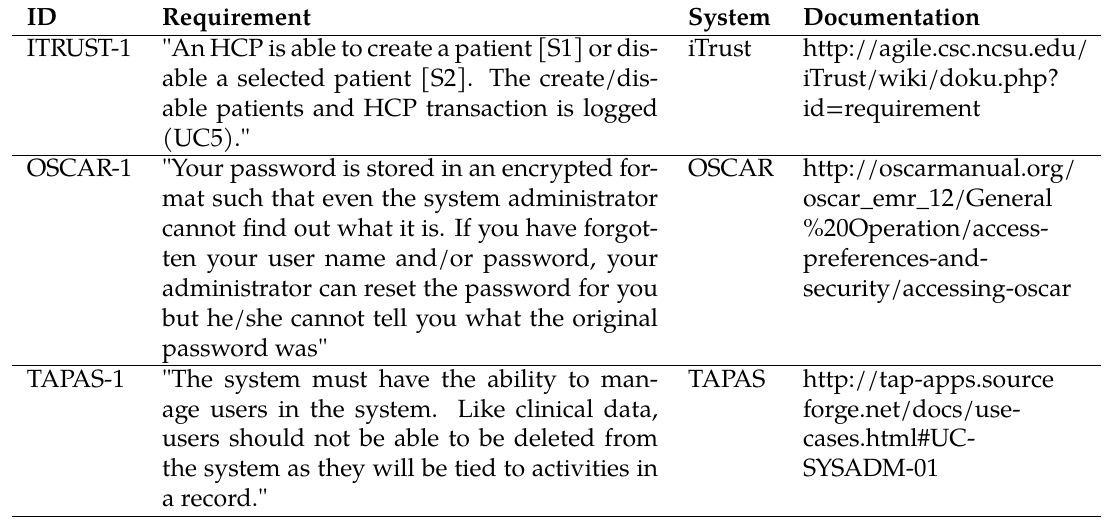
Table 4: Some specific requirements extracted from the available documentation of